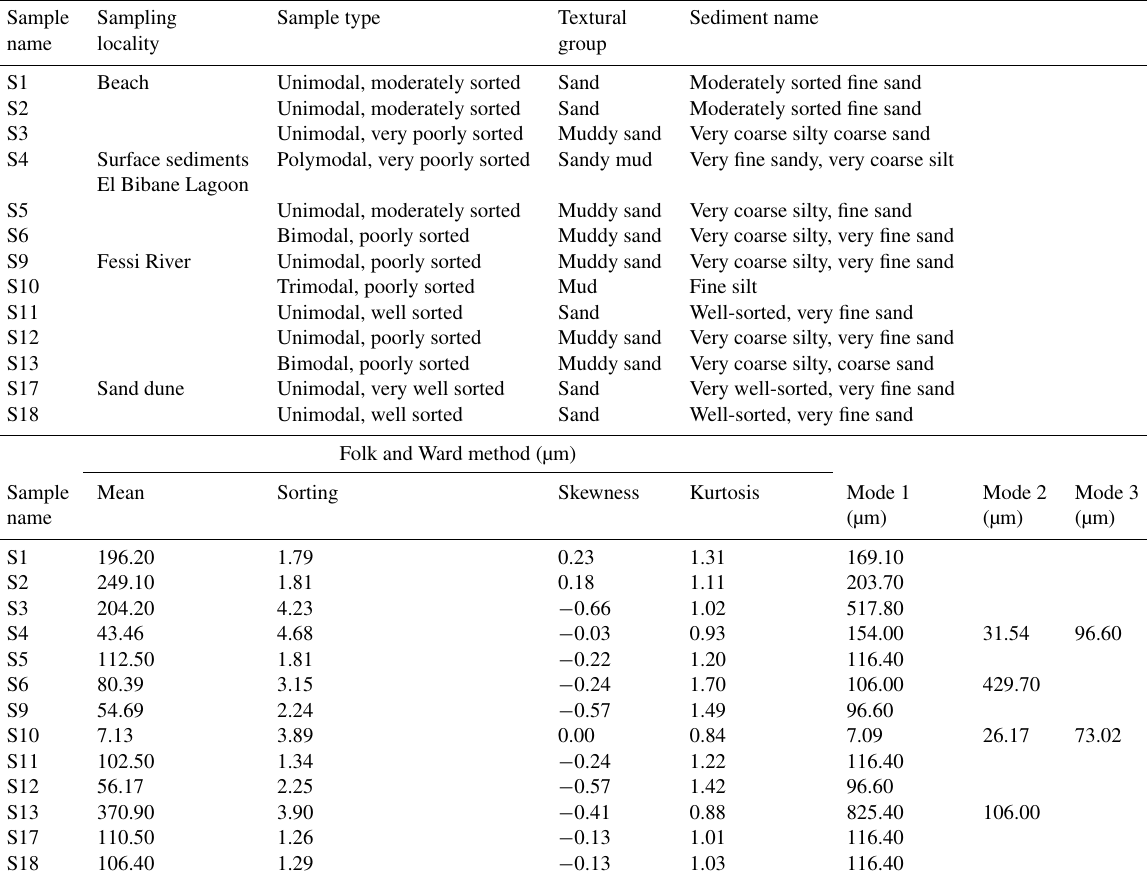
Table 2. Grain-size statistical analysis of surface samples from the watershed of the El Bibane Lagoon. Sample